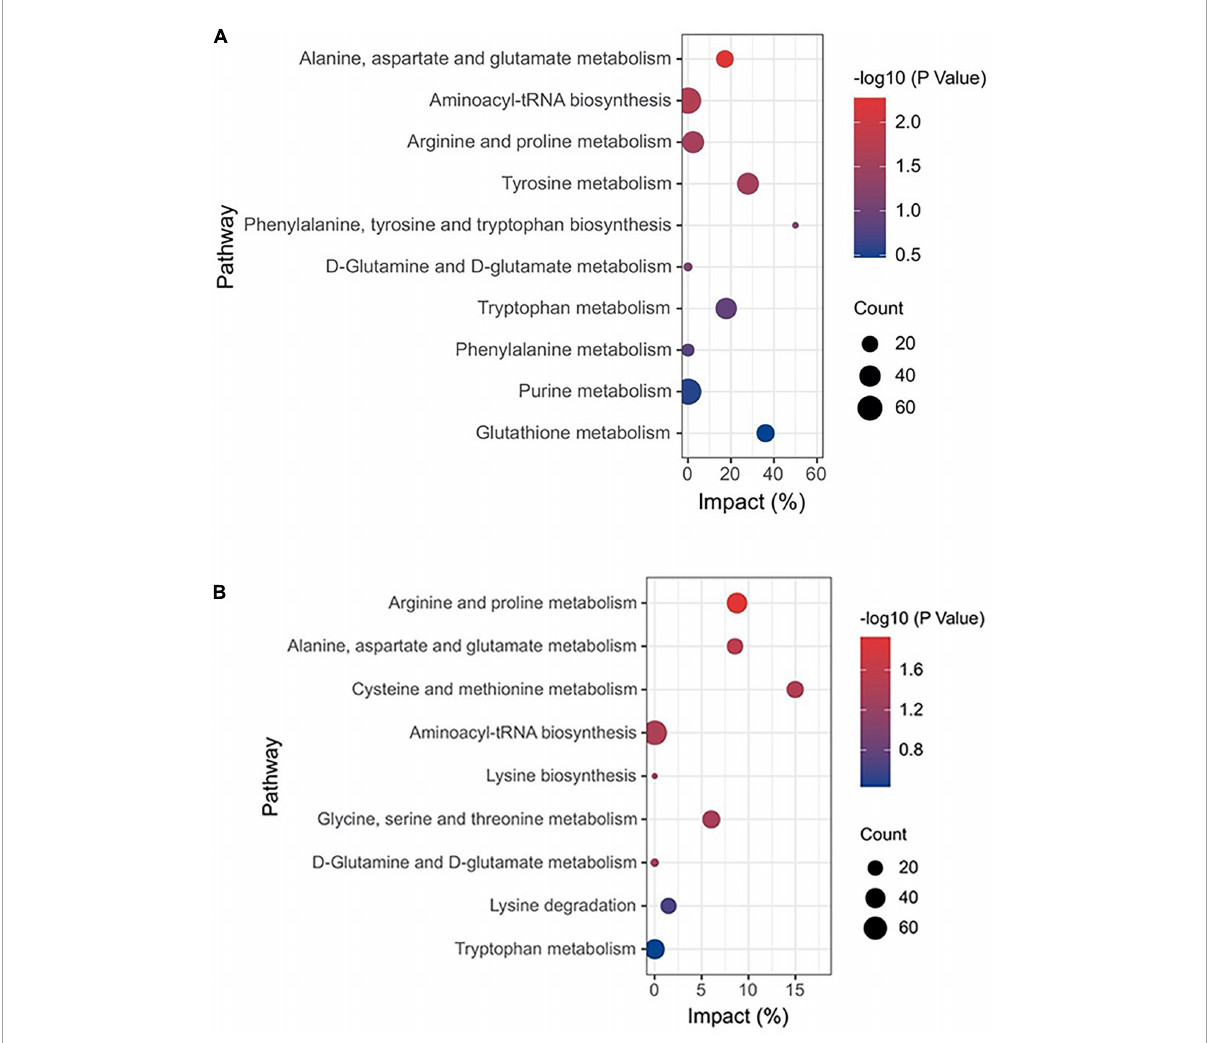
FIGURE6 KEGG function annotation analysis of plasma metabolites in Ira rabbits. (A) The bubble plot of KEGG indicates different enrichments affected by C. butyricum of Ira rabbits at 53 days of age. (B) The bubble plot of KEGG indicates different enrichments affected by C. butyricum of Ira rabbits at 67 days of